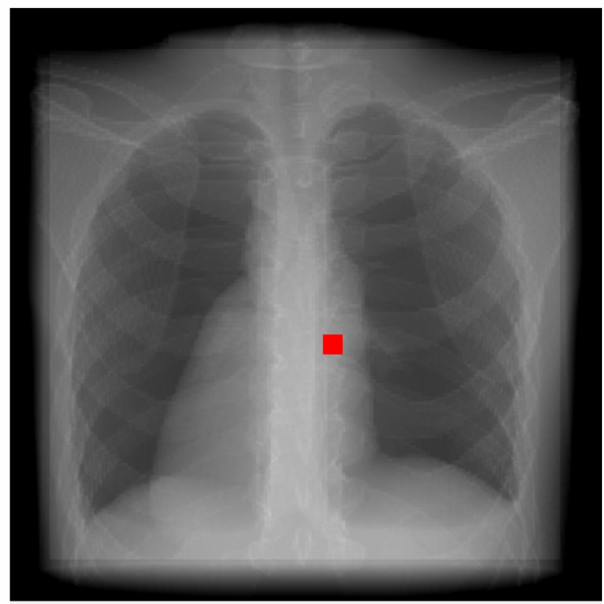
Figure 21. Relative position of a deep lying